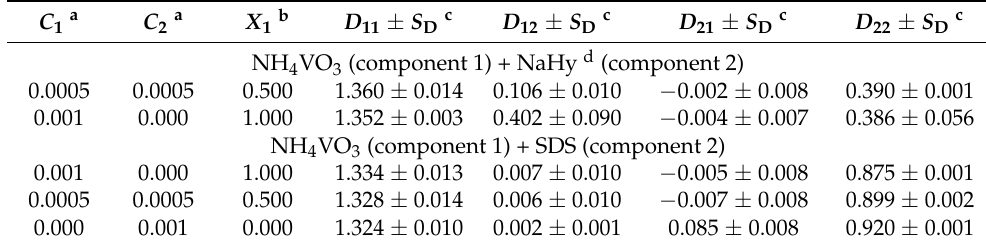
Table 3. Experimental apparent ternary diffusion coefficients ( D 11 , D 12 , D 21 , and D 22 ) of